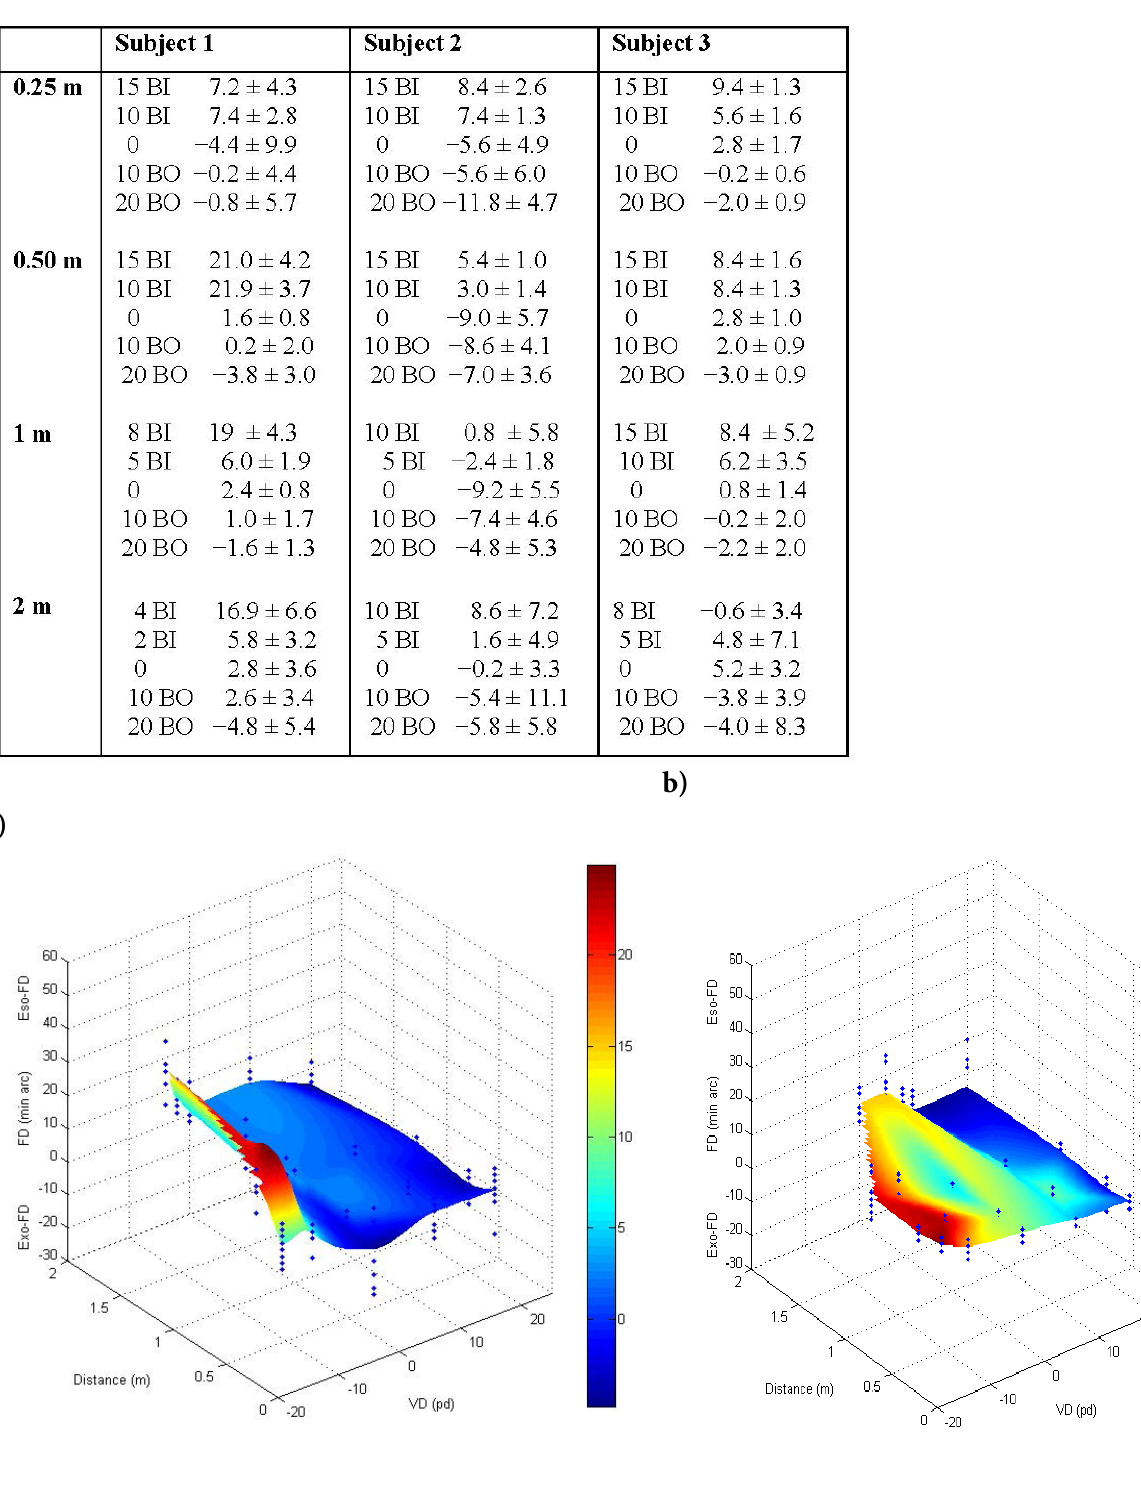
Table 1. Means and standard deviations for fixation disparities (FD) measured for three young subjects at four different stimulus distances (0.25, 0.5 , 1 and 2 m) under different vergence demands induced with Base In (BI) or Base Out (BO) prism. In some instances, the subject concerned had difficulty fusing under the vergence demand and prism had to be reduced - this was noted for the greater stimulus distances such as 1 or 2 m and with demand on divergence (using BI prism) rather than convergence (with BO prism). The units are min arc throughout the table and positive and negative values refer to eso-FD and exo-FD respectively. All means are for samples of ten ( N =10) measurements each obtained for the specified vergence demand and stimulus